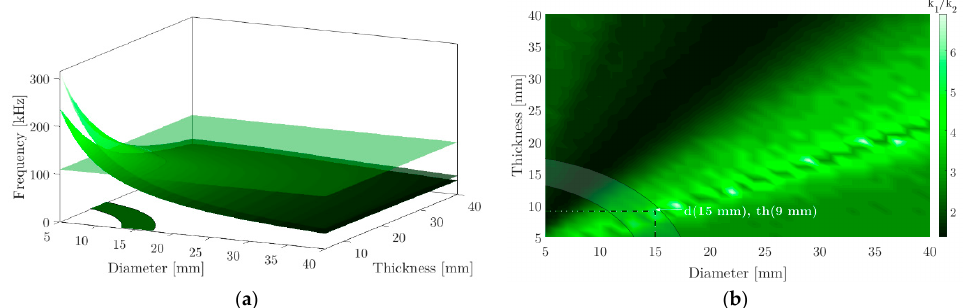
Figure 8. ( a ) Resonance and anti-resonance frequency for the first vibration mode in terms of the diameter and thickness simulated. The horizontal plane represents the central frequency of the pressure pulse of Figure 5a; ( b ) Ratio k 1 / k 2 for the first two modes of vibration. The shaded zone represents the area with the best diameter and thickness ratio is optimizing in this region the sensitivity and frequency response of piezoelectric ceramics.